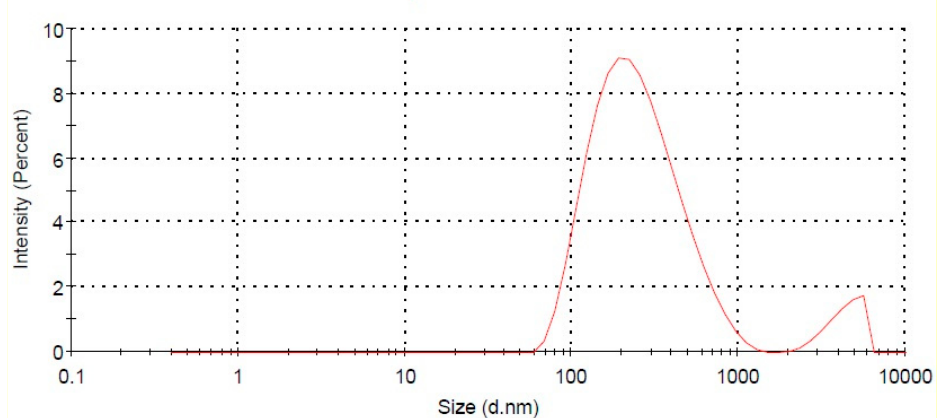
Figure 1. Particle size of optimized SLNs (F2) measured by the dynamic light scattering (DLS) method.